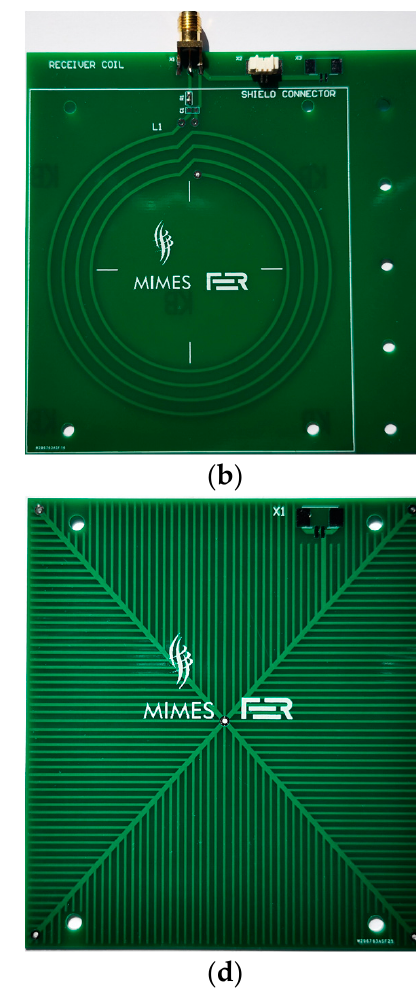
Figure 4. PCB coils and shields: ( a ) transmitter coil; ( b ) receiver coil; ( c ) comb C pattern shield; ( d ) comb X pattern shield.